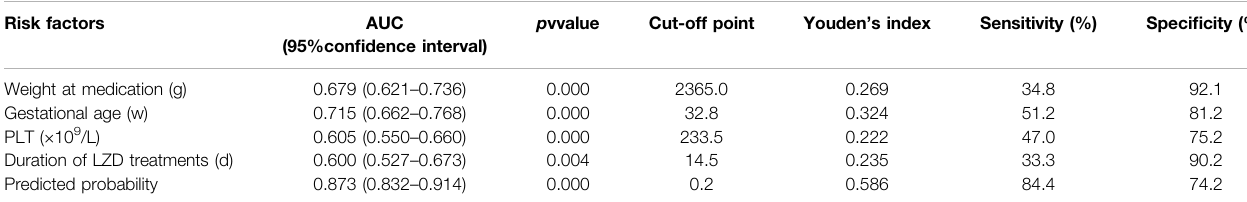
TABLE 1 | Area under the curve and cut-off values of receiver operating characteristic curve for prediction of thrombocytopenia in neonates on LZD treatment.